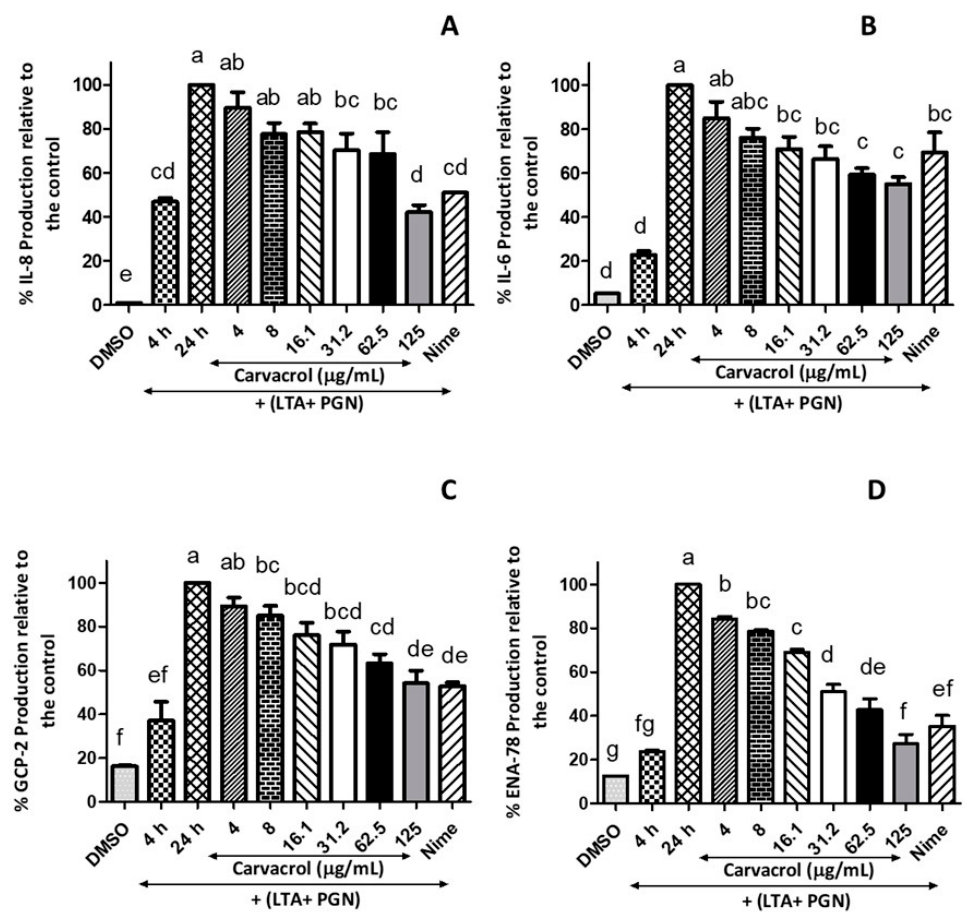
Figure 5. Inhibitory effects of carvacrol on the production of pro-inflammatory cytokines by LTA + PGN-stimulated human tonsil epithelial cells; Tonsil cells were treated with carvacrol (4–125 µ g/mL) for 20 h after 4 h stimulation with LTA + PGN mixture (5 µ g/mL, each). Supernatants were harvested 20 h after stimulation. Concentrations of ( A ) IL-8, ( B ) IL-6, ( C ) CGP-2, and ( D ) ENA-78 in the culture supernatants were determined by ELISA. Results are shown as the mean ± SE. Data are representative of three independent experiments conducted in triplicate. The different letters above the columns (a–g) show that the means of different groups were significantly different ( p < 0.05) by one-way analysis of variance. Nime: nimesulide; IL-8: interleukin-8; IL-6: interleukin-6; ENA-78: epithelial-derived neutrophil-activating protein-78; GCP-2: granulocyte chemotactic protein-2; LTA: lipoteichoic acid; and PGN: peptidoglycan.